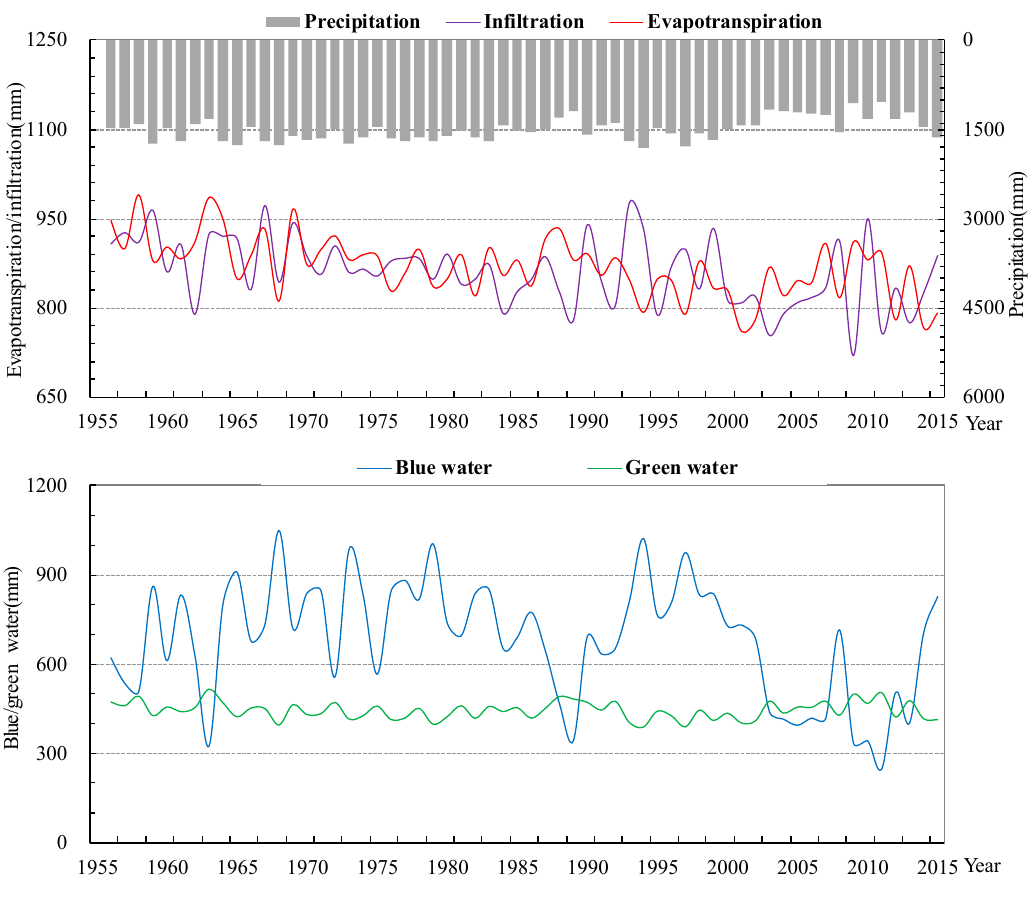
Figure 12. Annual variability of water cycle fluxes in KMRSC. Table 7. Mann–Kendall test results and the CV values for water cycle fluxes in KMRSC.